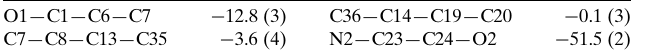
Table 1 Selected torsion angles ( (cid:3) ) for (I).